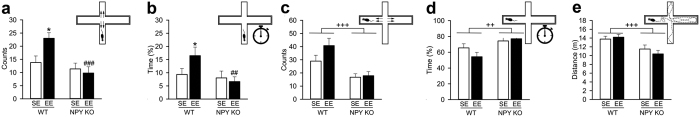
NPY KO abolishes the anxiolytic effects of EE in the EPM.(a) The number of open arm entries (interaction: F(1,32) = 5.150, P = 0.030; post-hoc test, *P < 0.05 vs. WT/SE; ###P < 0.001 vs. WT/EE) and (b) the time spent on the open arms of the EPM show an anxiolytic effect of EE only in WT animals (interaction: F(1,32) = 3.015, P = 0.092; post-hoc test, ##P < 0.01 vs. WT/EE). (c) The number of closed arm entries (significant main effect of genotype: F(1,32) = 18.283, P < 0.001), (d) the time spent on the closed arms (significant main effect of genotype: F(1,32) = 9.286, P = 0.005) and (e) total distance travelled (significant main effect of genotype: F(1,32) = 15.140, P < 0.001) reveal an hypo-explorative and hypo-locomotive phenotype of NPY KO mice. The time spent on the open and closed arms is expressed as percentage of the 5-min test duration. Values represent means ± SEM. ++P < 0.01, +++P < 0.001 for main effect: NPY KO vs. WT independently of housing condition; n = 9–10.